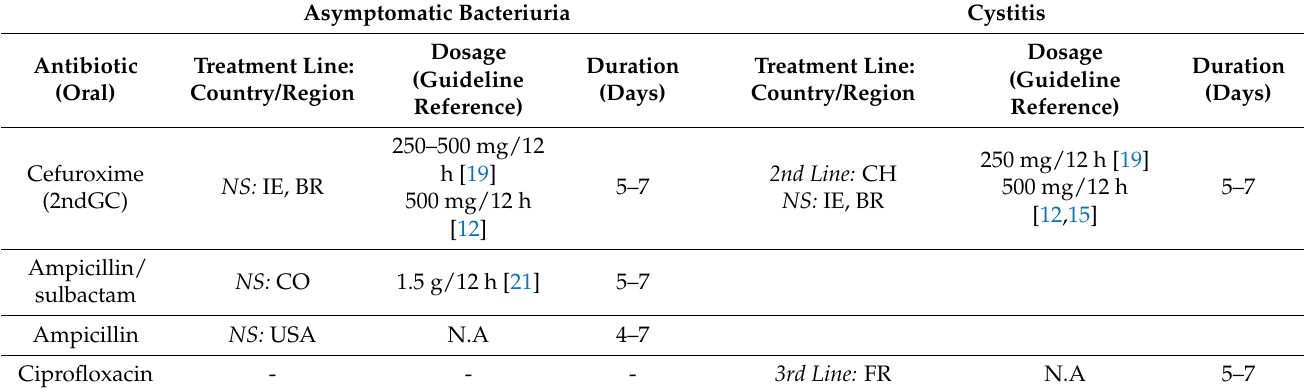
Table 3. Cont. Asymptomatic